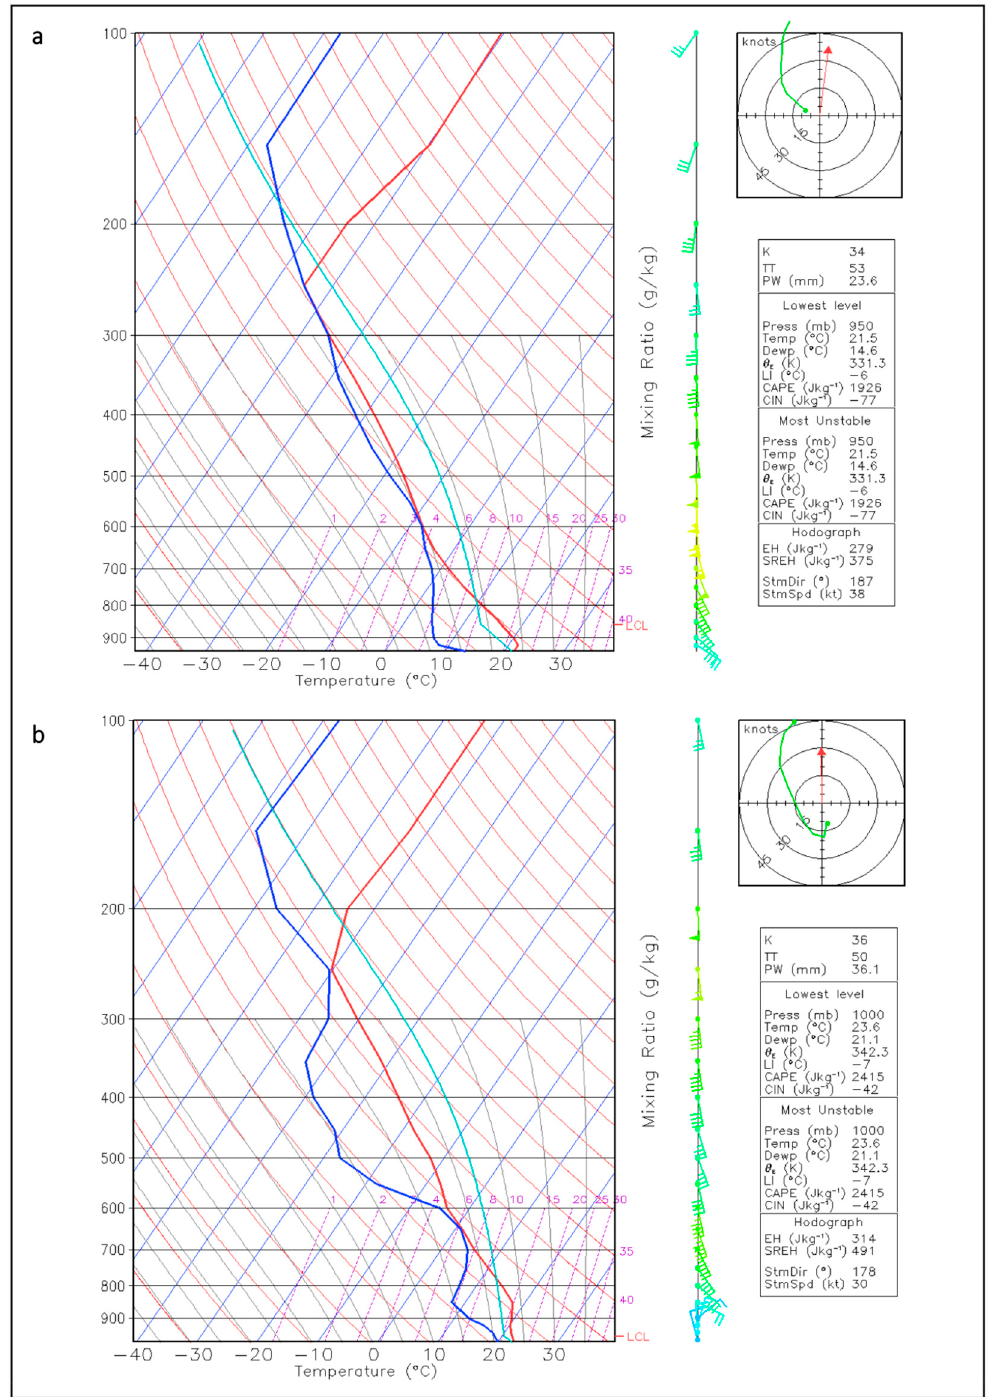
Figure 3. Skew-T diagram at ( a ) 1200 UTC 3 June 2017 and ( b ) 0900 UTC 18 June 2017, obtained by the GFS/NCEP model forecasts for the coordinates of the observed tornadoes. Table 2. Diagnostic variables calculated according to the GFS/NCEP (first line) and GEM/CMC (second line) model outputs (12-h forecasts from the 0000 UTC 3 June 2017 and 0000 UTC 18 June 2017, respectively). CIN and STP were obtained only for the GFS/NCEP data.